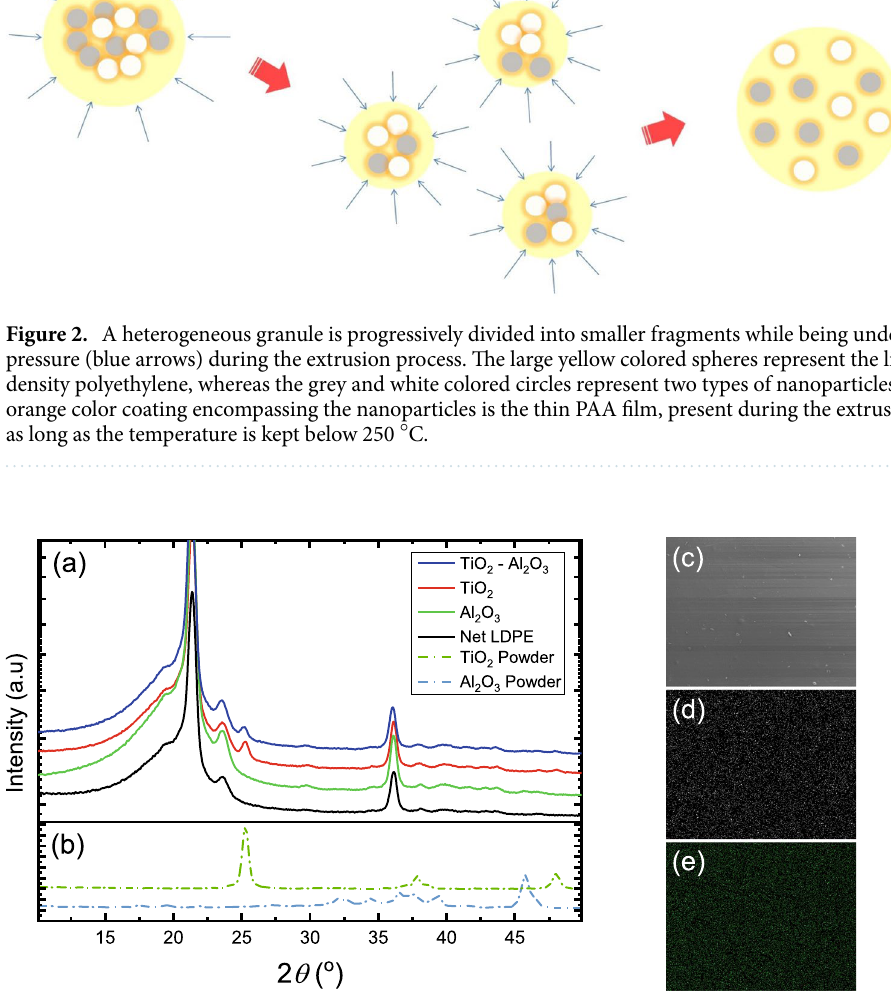
Figure 3. ( a ) XRD patterns of Net LDPE and of TiO 2 , Al 2 O 3 and TiO 2 –Al 2 O 3 nanoparticles embedded in LDPE from 10 ◦ to 50 ◦ 2 θ . ( b ) XRD patterns of TiO 2 and Al 2 O 3 granulated powders. ( c ) SEM image of an LDPE film containing TiO 2 –Al 2 O 3 nanoparticles and the corresponding EDX map showing the spatial distribution